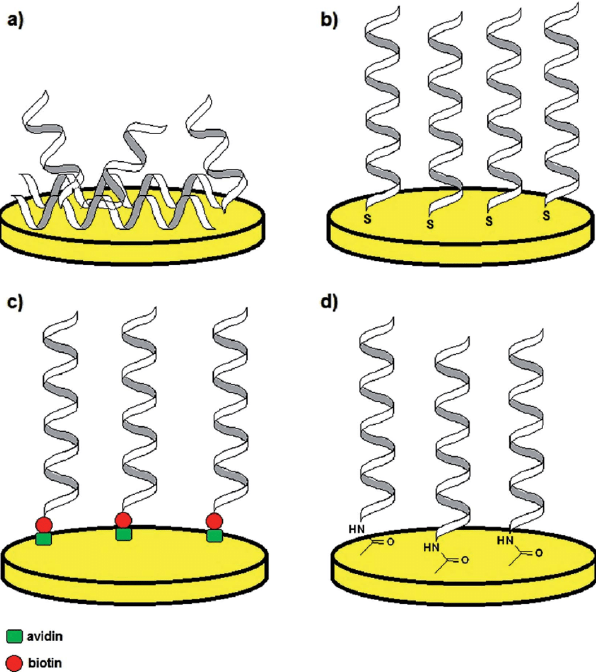
Figure 2. Examples of aptamer immobilization methods: via physical adsorption ( a ); thiol self-assembled monolayers (SAMs) ( b ); avidin-biotin complex formation ( c ); and surface activation with EDC/NHS (1-ethyl-3-(-3-dimethylaminopropyl) carbodiimide hydrochloride/N-hydroxysuccinimide) ( d ). Reproduced from [29] with permission from the Royal Society of Chemistry.